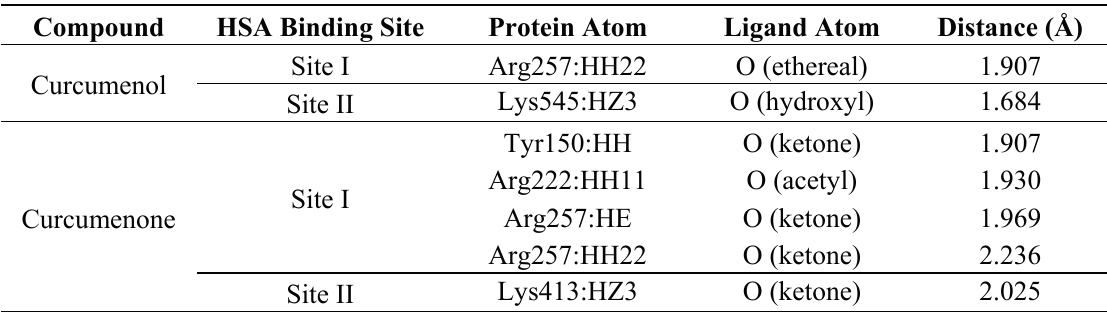
Table 2. Predicted hydrogen bonds between interacting atoms of the amino acid residues of HSA (1BM0) and the ligands at site I and site